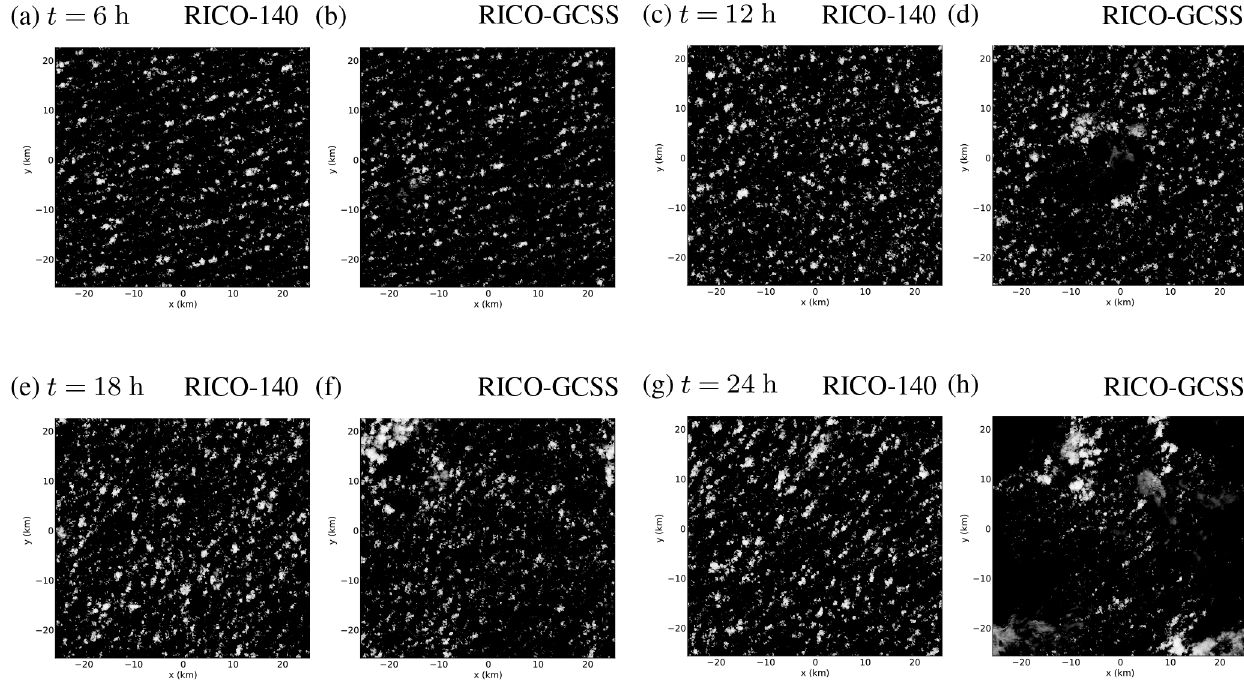
Figure 1. Snapshots taken every 6h during the simulation showing the cloud albedo: the higher cloud droplet number density RICO case (RICO-140) vs. the standard RICO case (RICO-GCSS).